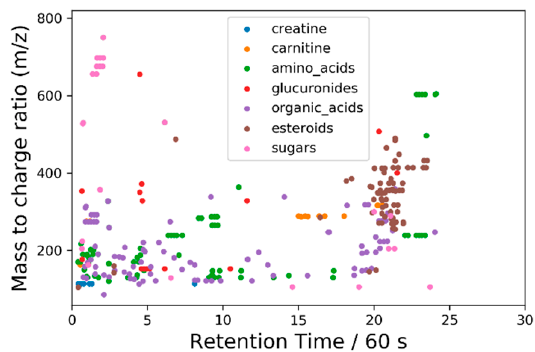
Figure 7. Chemical classes corresponding to selected LC-MS spectral features. This plot has the same scale as Figure 6.